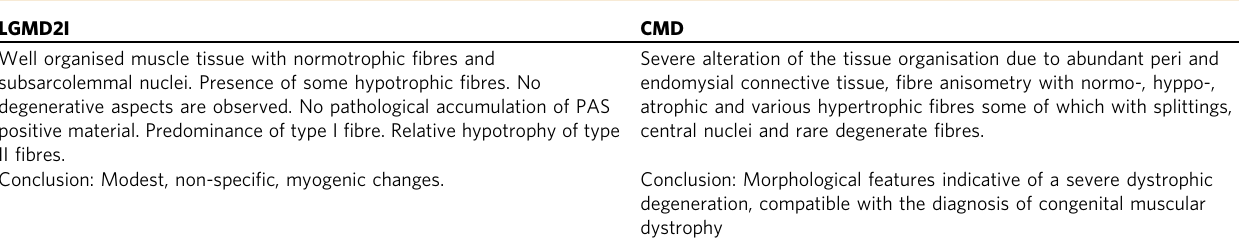
Severe alteration of the tissue organisation due to abundant peri and endomysial connective tissue, fi bre anisometry with normo-, hyppo-, atrophic and various hypertrophic fi bres some of which with splittings, central nuclei and rare degenerate fi bres.